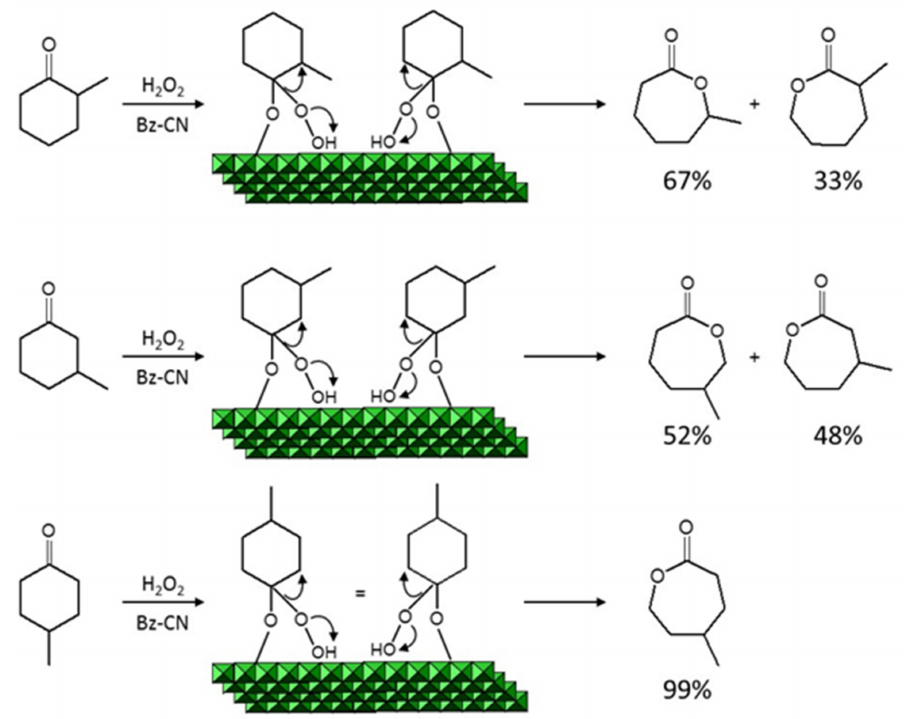
Scheme 3. Structure of the cyclic ketones studied. ( a ) Difference between the cyclic ketones with five to seven rings ( b ) Difference between the cyclohexanones bearing a methyl substituent at position 2, 3 or